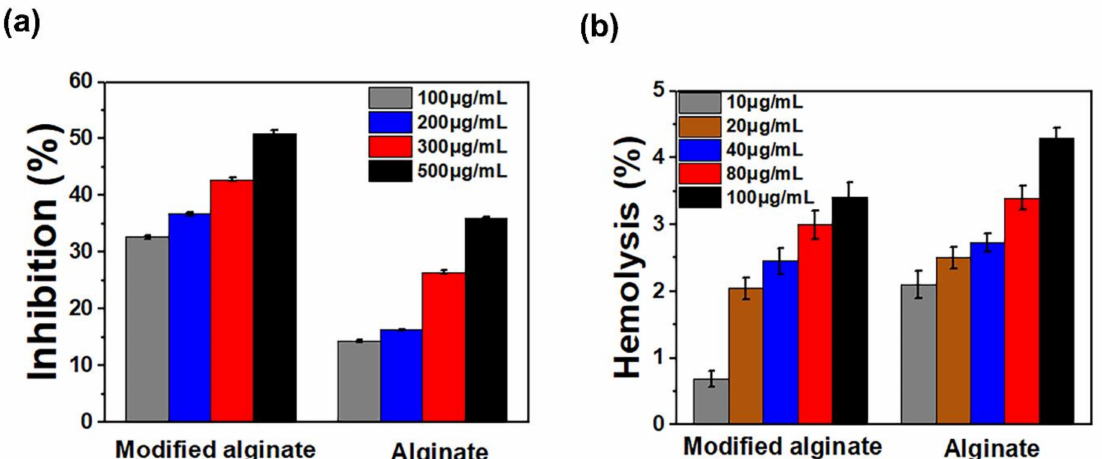
Figure 9. ( a ) Anti-inflammatory properties of alginic acid and its aromatic derivative showing the inhibition of BSA protein denaturation. Each bar indicates mean ± standard deviations of three replications. ( b ) Hemolysis activity of alginate and its aromatic derivative at different polymer